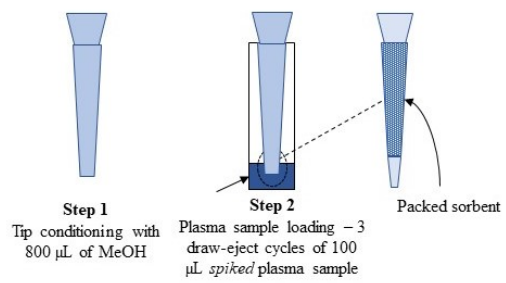
Figure 3. The schematic diagram for in-tip SPME procedure.